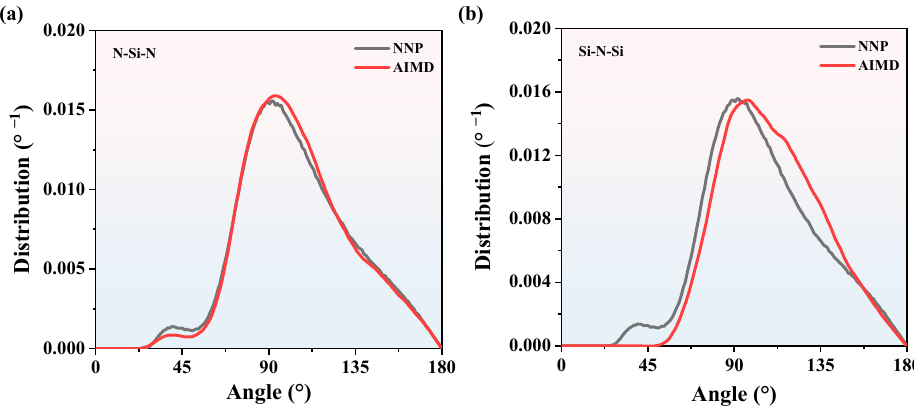
Figure 5. The BADs comparison of Si 3 N 4 between NNP + MD and AIMD at 2000 K. ( a ) the N-Si-N BADs, ( b ) the Si-N-Si BADs.